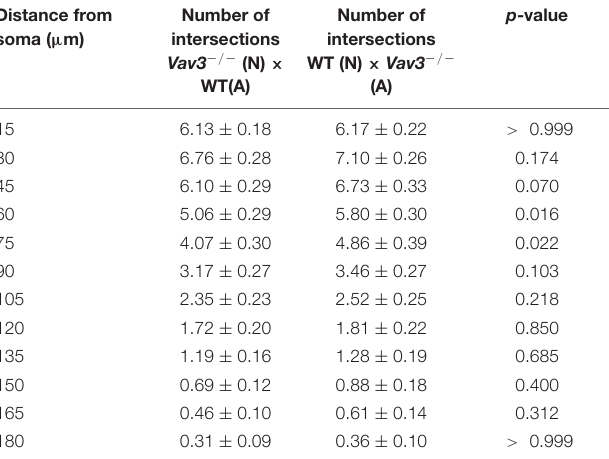
TABLE 5 | Intersection numbers of Vav3 − / − neurons in comparison to the control condition after cultivation time of 17 days. Distance from soma ( µ m)